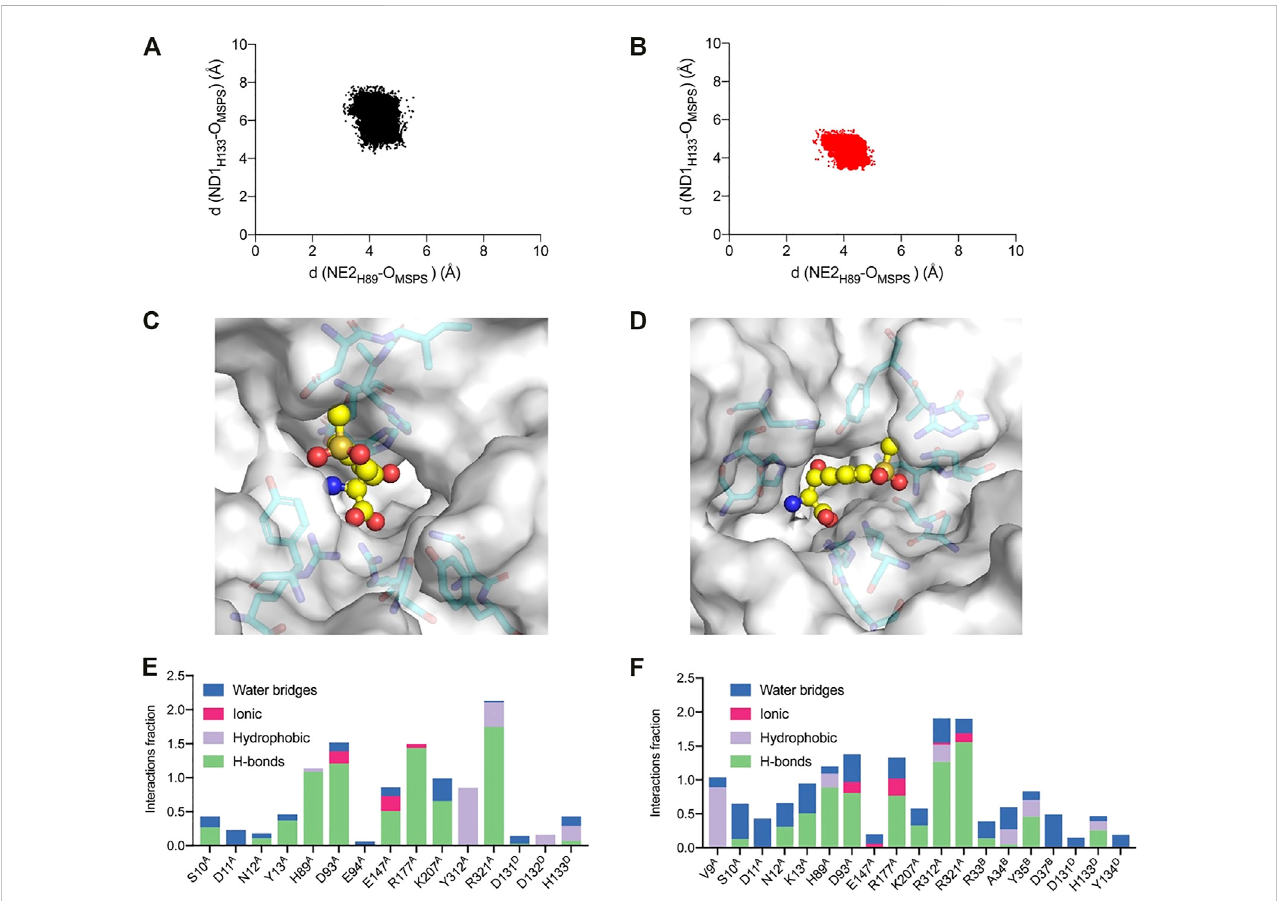
FIGURE 9 AnalysisoftheMDsimulations.Conformationdistributionof (A) WTand (B) A9V/Y13K/Y312R.TheactivesitesadjacenttotheMSPSof (C) WTand (D) A9V/ Y13K/Y312R. The protein is represented as a surface in gray. The active sites are represented as sticks. The ligand MSPS is indicated by sphere. Protein interactionswiththeMSPSof (E) WTand (F) A9V/Y13K/Y312R.Theprotein-ligandinteractionsarecategorizedintofourtypes:waterbridges(blue),ionic(rosy), hydrophobic (purple) and hydrogen bonds